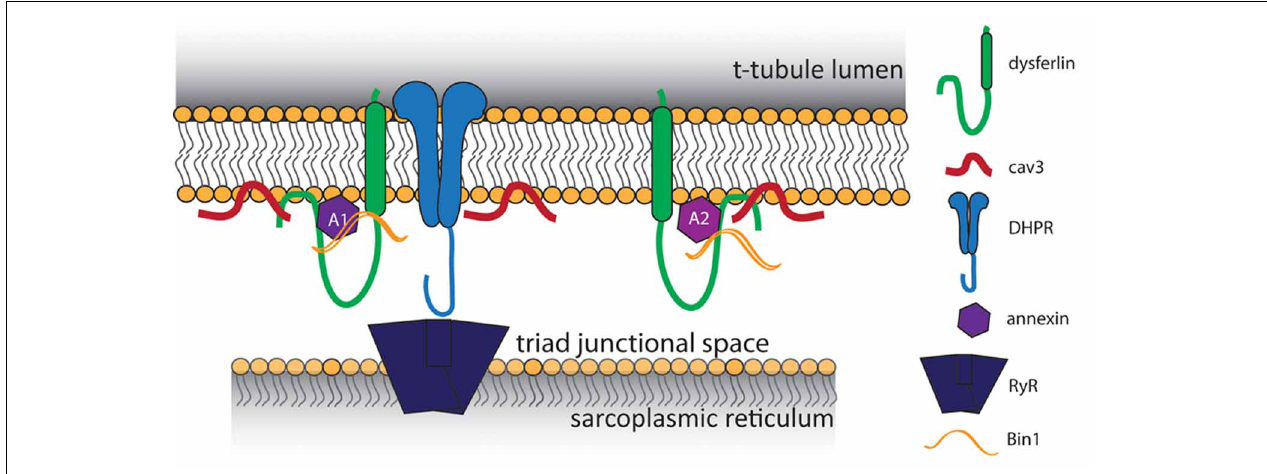
FIGURE 1 | Proposed model of t-tubule dysferlin. Dysferlin is anchored in the t-tubule membrane by its transmembrane domain, with its extreme C-terminus exposed to the lumen of the t-tubule. In close proximity to dysferlin are proteins of the triad junction, the L-type Ca 2 + channel (DHPR) in the t-tubule